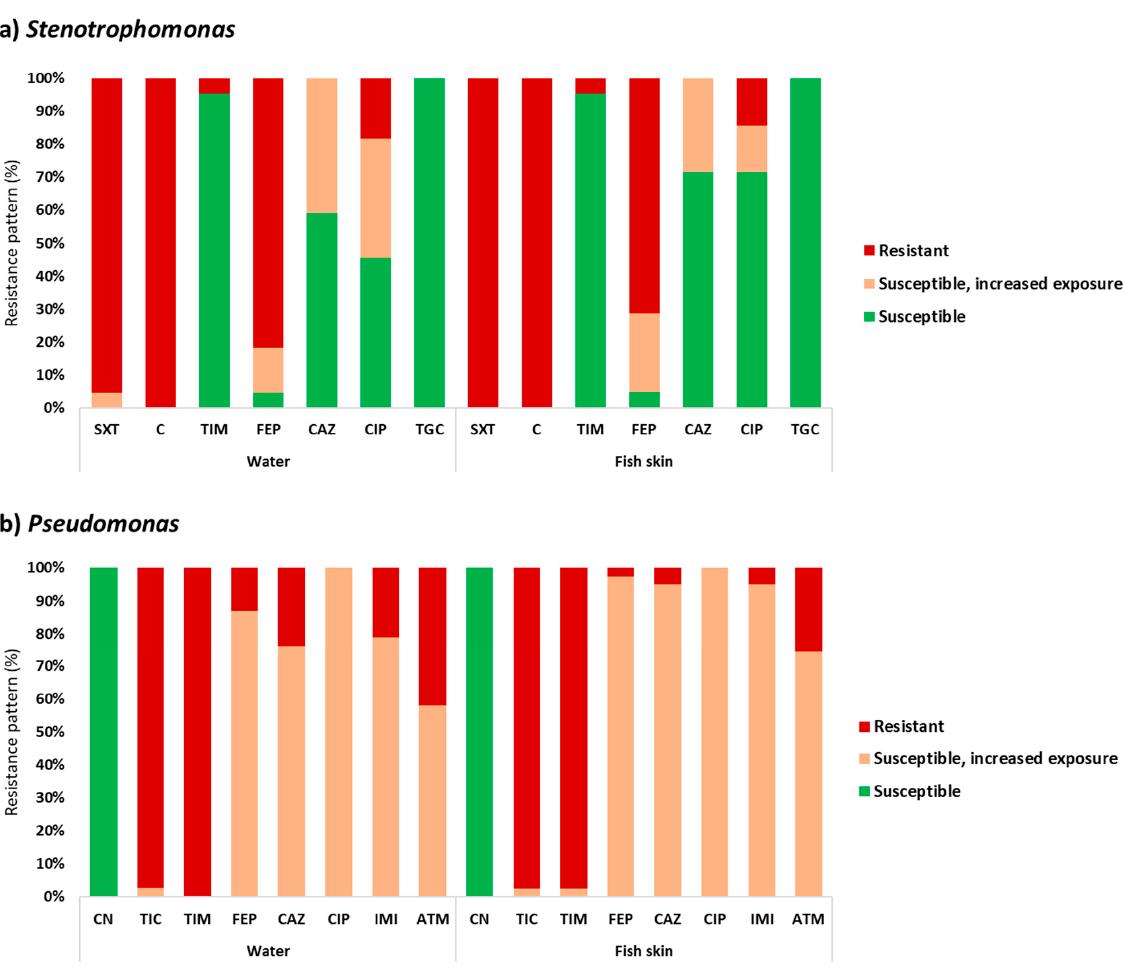
Figure 2. Resistance pattern (susceptible; susceptible, increased exposure; and resistant) of isolated bacteria according to the genera ( Stenotrophomonas and Pseudomonas ) and type of sample (water or fish skin). Aztreonam: ATM; cefepime: FEP; ceftazidime: CAZ; chloramphenicol: C; ciprofloxacin: CIP; gentamicin: CN; imipenem: IMI; ticarcillin: TIC; ticarcil- lin/clavulanic acid: TIM; tigecycline: TGC; and trimethoprim/sulfamethoxazole: STX.